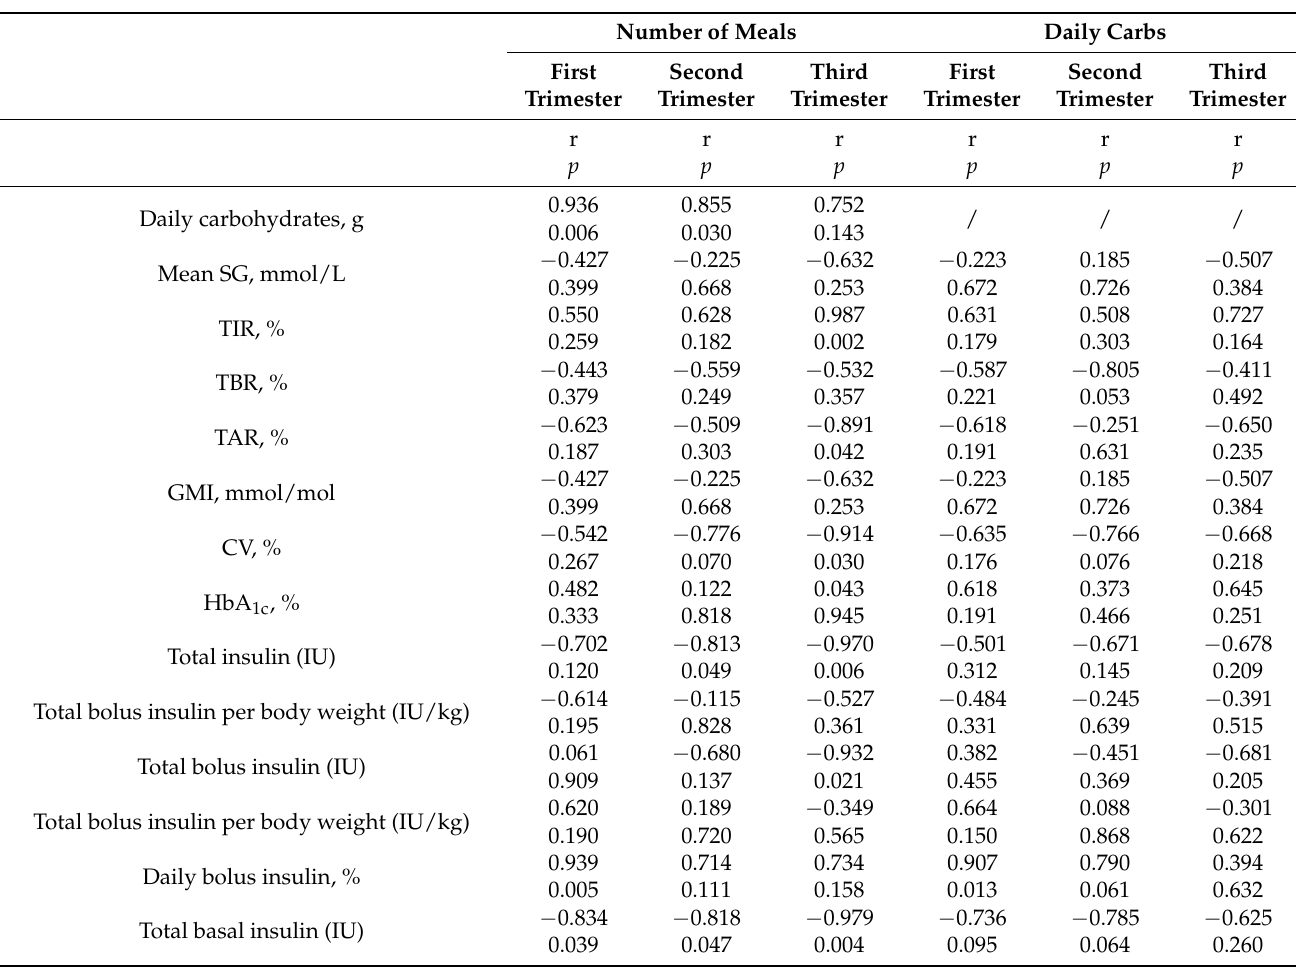
Table 3. Association of the number of meals/daily carbs with glycemic parameters for the second pregnancy (on HCLs), described using the Pearson r correlation